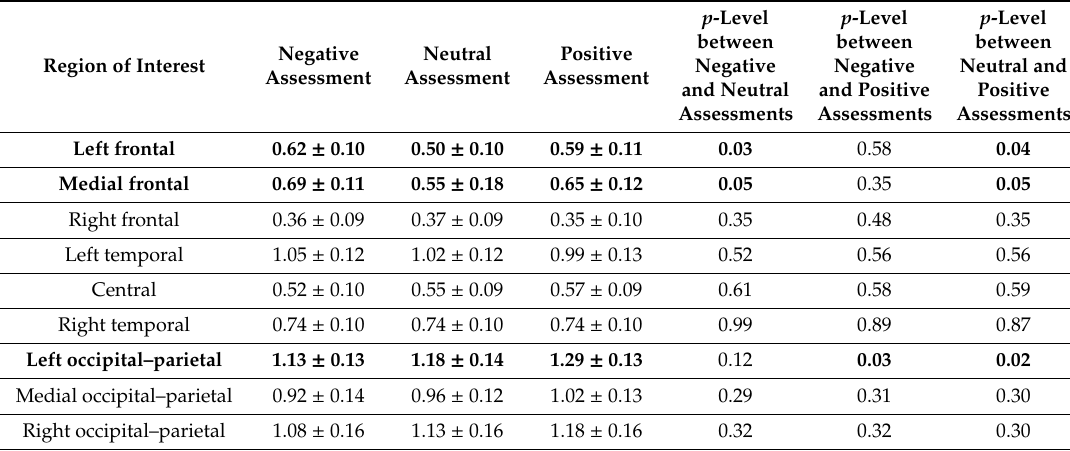
Table 4. The di ff erences in the P600 maximal amplitude (in µ V) between various assessments among cortical regions. Significantly di ff erent values are in